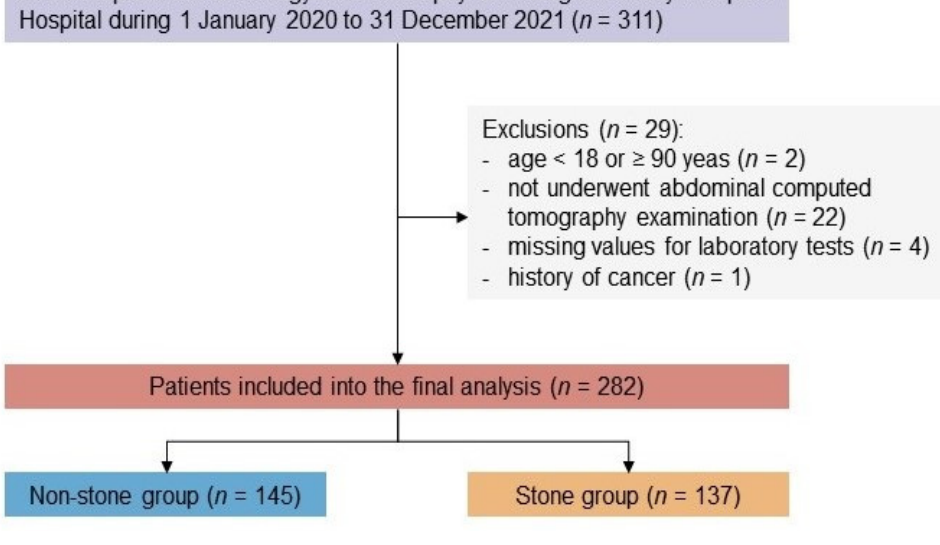
Figure 1. Flowchart of the study population.